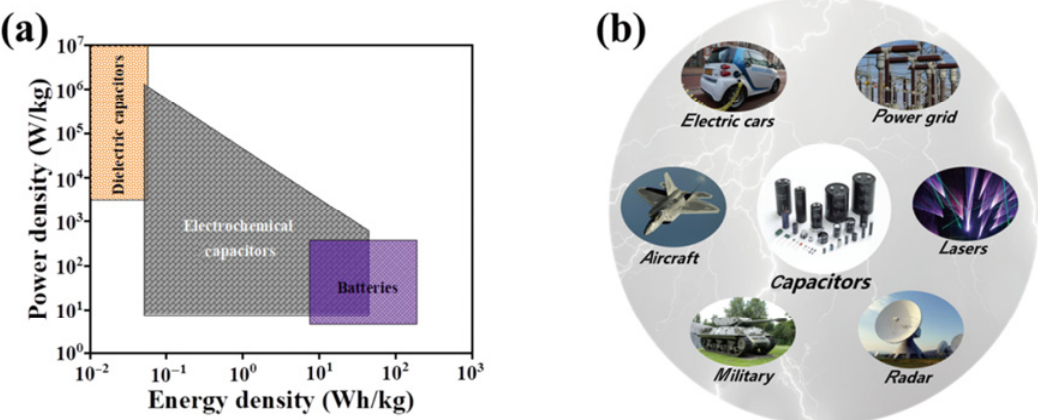
Fig. 1 (a) Comparison of power density and energy density capabilities of dielectric capacitors, electrochemical capacitors, and batteries [9]. (b) Applications for dielectric capacitors